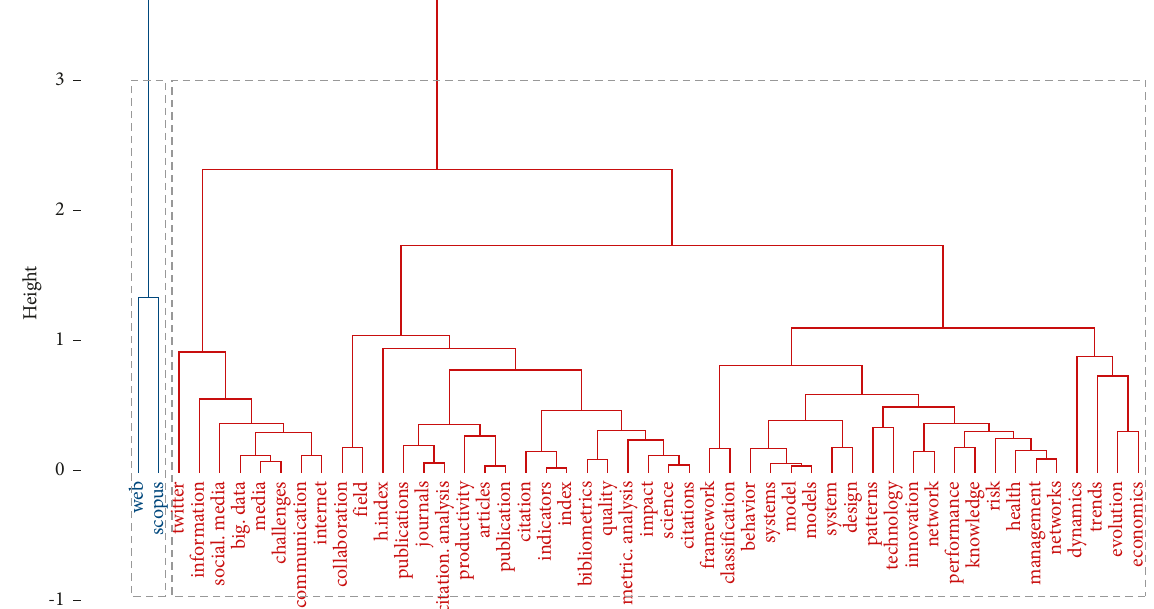
Figure 13: Keyword hierarchical cluster analysis by tree